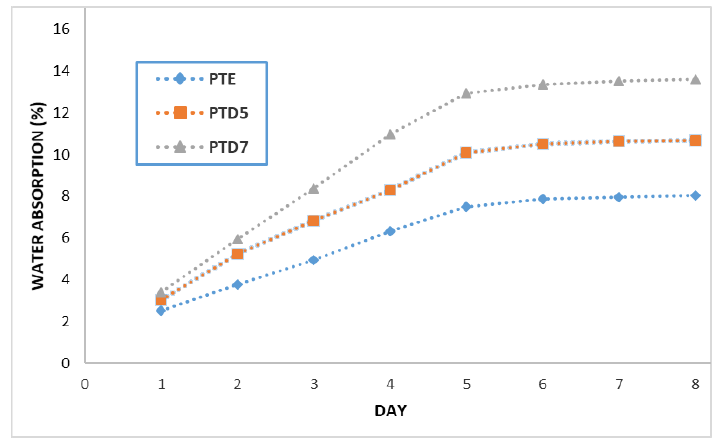
Figure 7. Variation of water absorption in percentage of PTE, PTD5 and PTD7